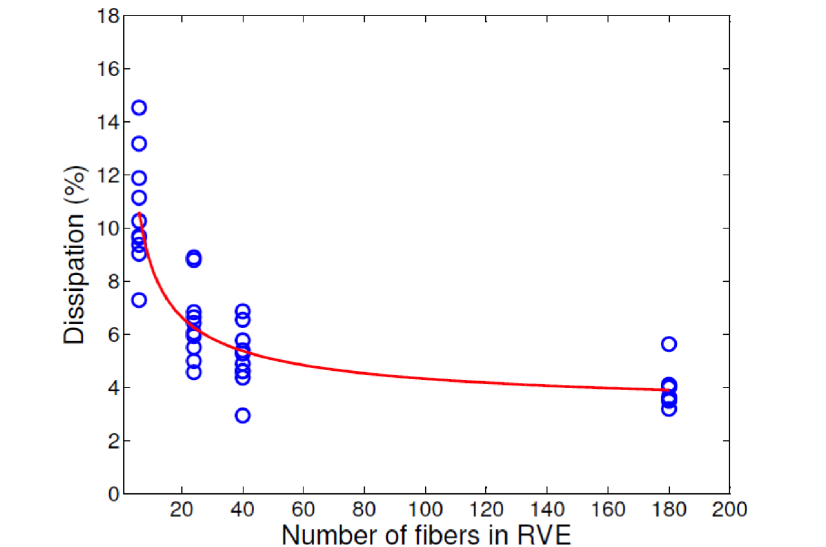
Figure 21. Percentage of energy dissipated (prior to peak) to the total energy dissipated in the unit cell, as a function of unit cell